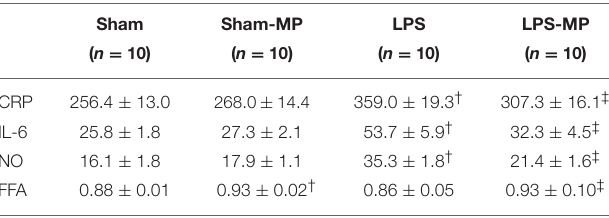
TABLE 2 | Proinflammatory cytokines and plasma FFA in the LPS-challenged rats treated with MP. Sham